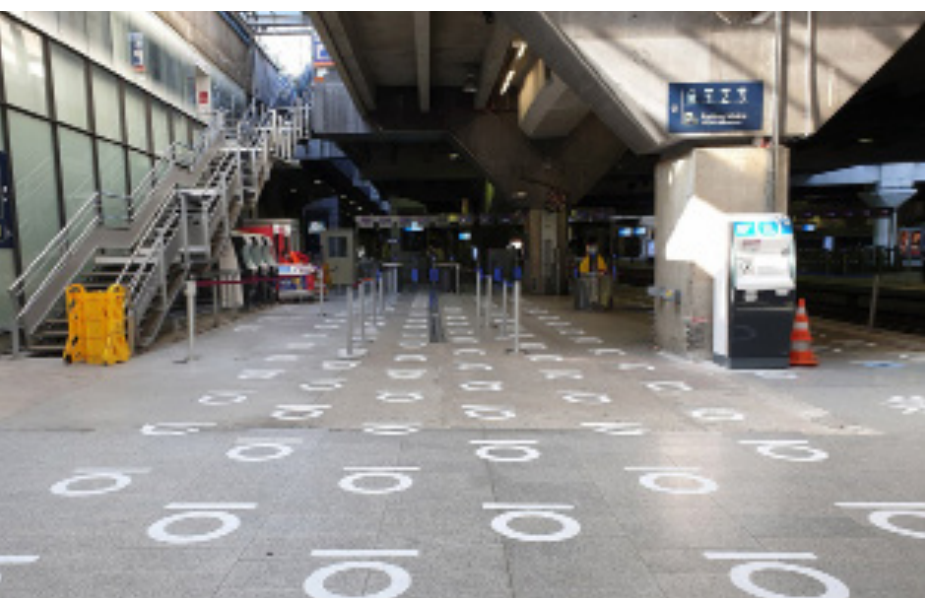
Fig. 1 Gare Montparnasse, 2020. ©Sylvain Perichon - www.